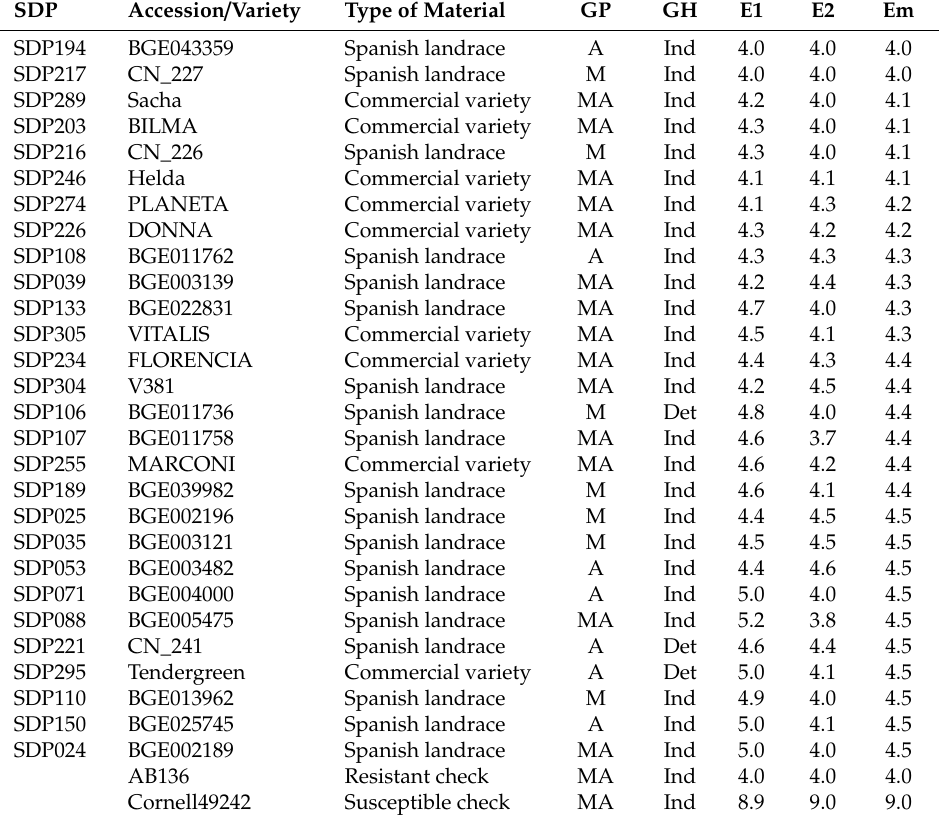
Table 1. Lines included in the SDP (Spanish Diversity Panel) showing partial resistance against the Sclerotinia sclerotiorum local isolate. Resistant and susceptible checks are included. The severity scale value assigned in each evaluation (E1, E2, and Em) is indicated. According to Campa et al. [7], the accession / variety from which each SDP line was obtained, the gene pool (GP) assigned to each line (A, Andean; MA, Mesoamerican; M, recombinant between A and MA) and the growth habit (GH: det, determinate vs. ind, indeterminate) are indicated.